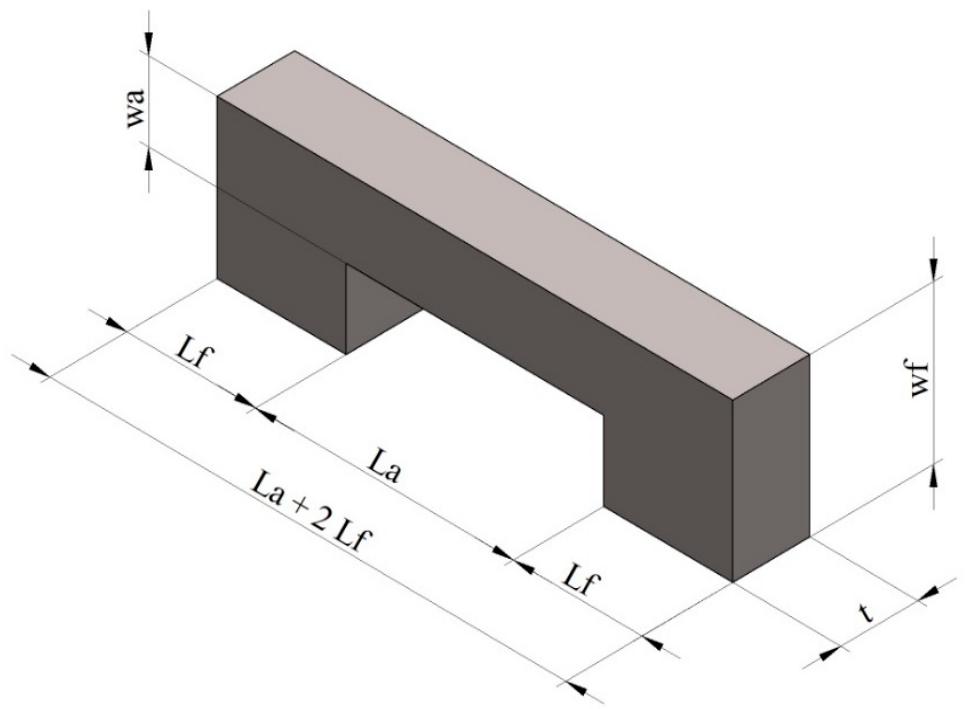
Figure 1. Dimensions of the micro beam.